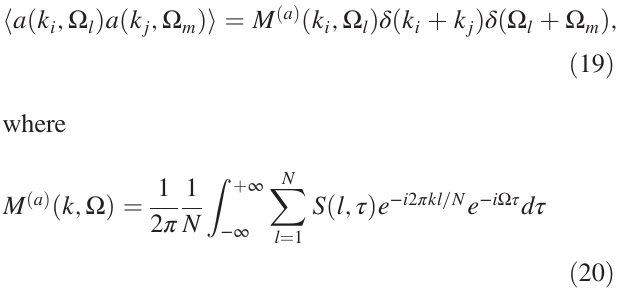
FIG. 2. Ratio between the number of ghost excitations N over the total number of waves N nonlinearity.